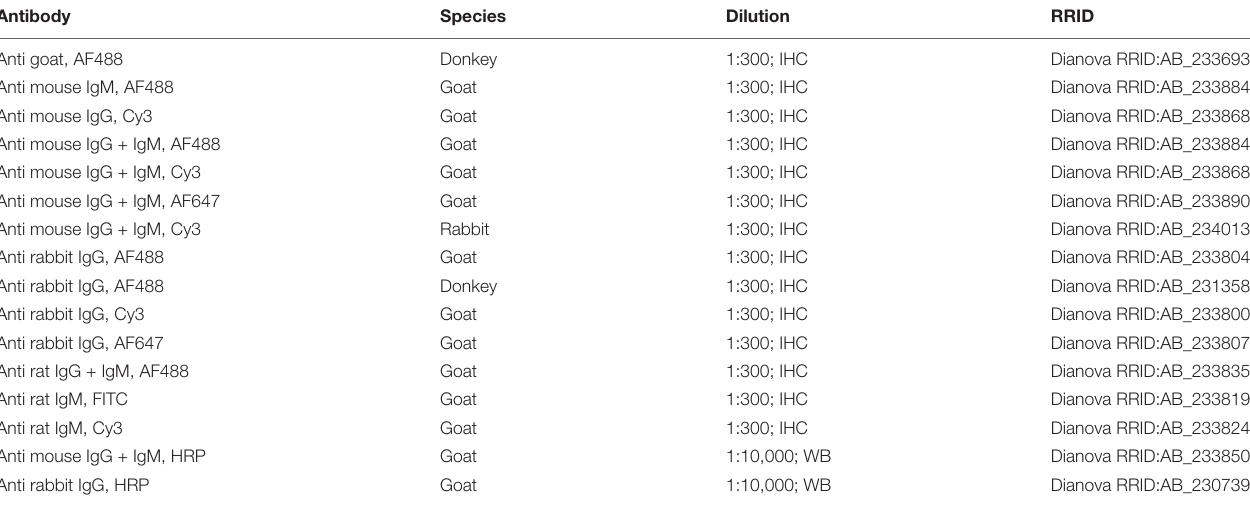
TABLE 2 | Secondary antibodies used for immunohistochemical analysis (IHC) and Western blot (WB). Antibody Species Dilution RRID Anti goat, AF488